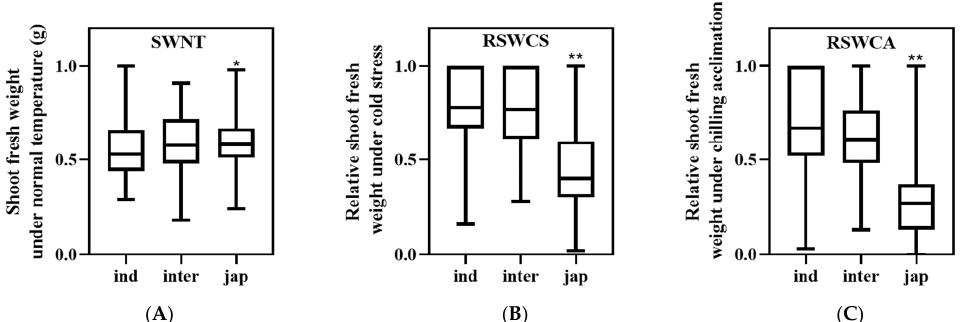
Figure 1. Comparison of shoot fresh weight of rice subpopulations under different temperature conditions. ( A – C ) The box plot of the response of three rice subpopulations seedlings to the normal temperature ( A ), cold stress ( B ), and chilling acclimation ( C ). SWNT (g), shoot fresh weight under normal temperature; RSWCS, relative fresh weight after cold stress; RSWCA, relative fresh weight after chilling acclimation; ind, indica subpopulation; inter, intermediate subpopulation; jap, japonica subpopulation. * and ** represent significant differences at the 0.05 and 0.01 levels; respectively.